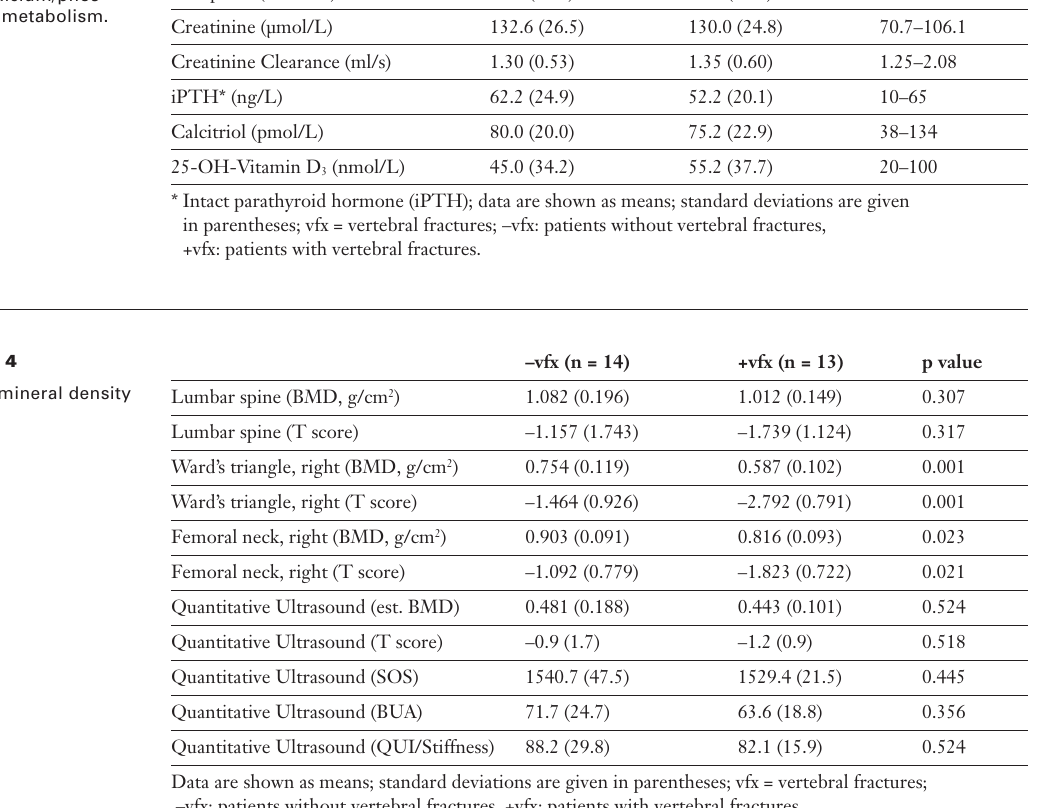
Biochemical parame- ters of renal function and calcium/phos- phate metabolism.